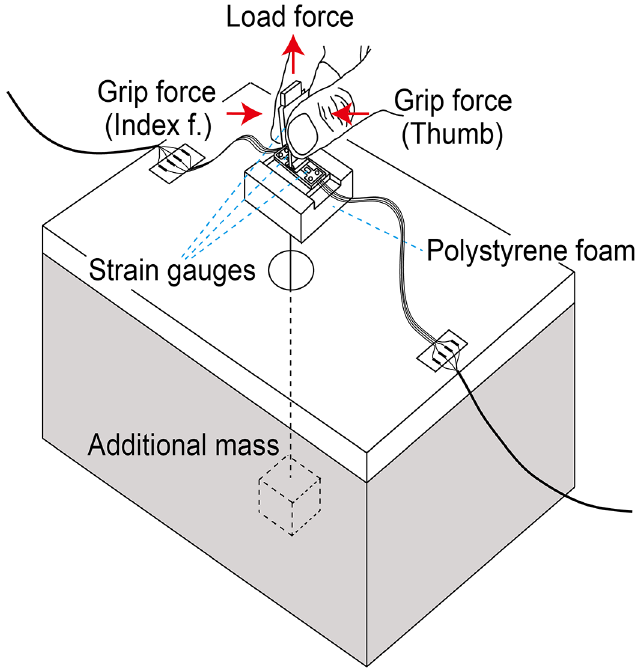
Fig 1. The light grip apparatus and the experimental table. The apparatus contained three sensors to measure grip and load forces.